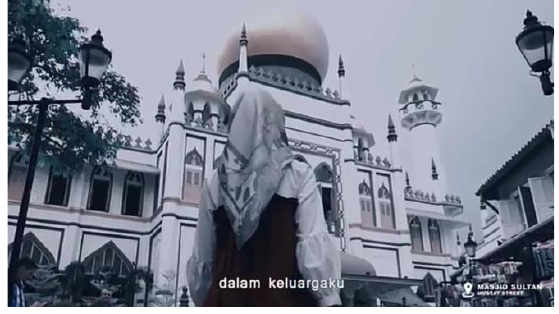
Figure 10: A Muslim Woman